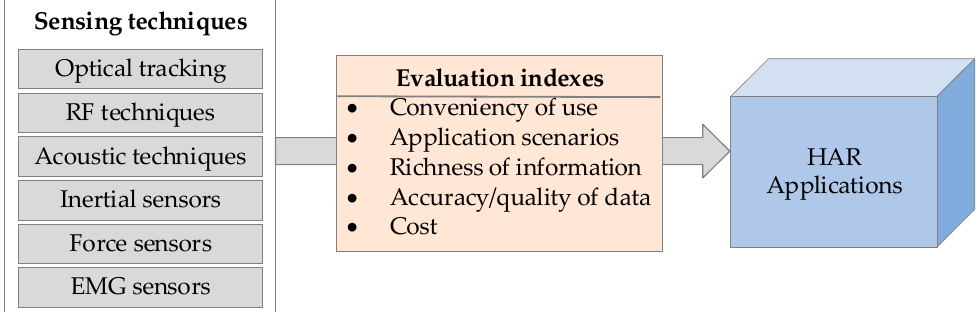
Figure 5. Taxonomy and evaluation indexes for HAR sensing techniques.